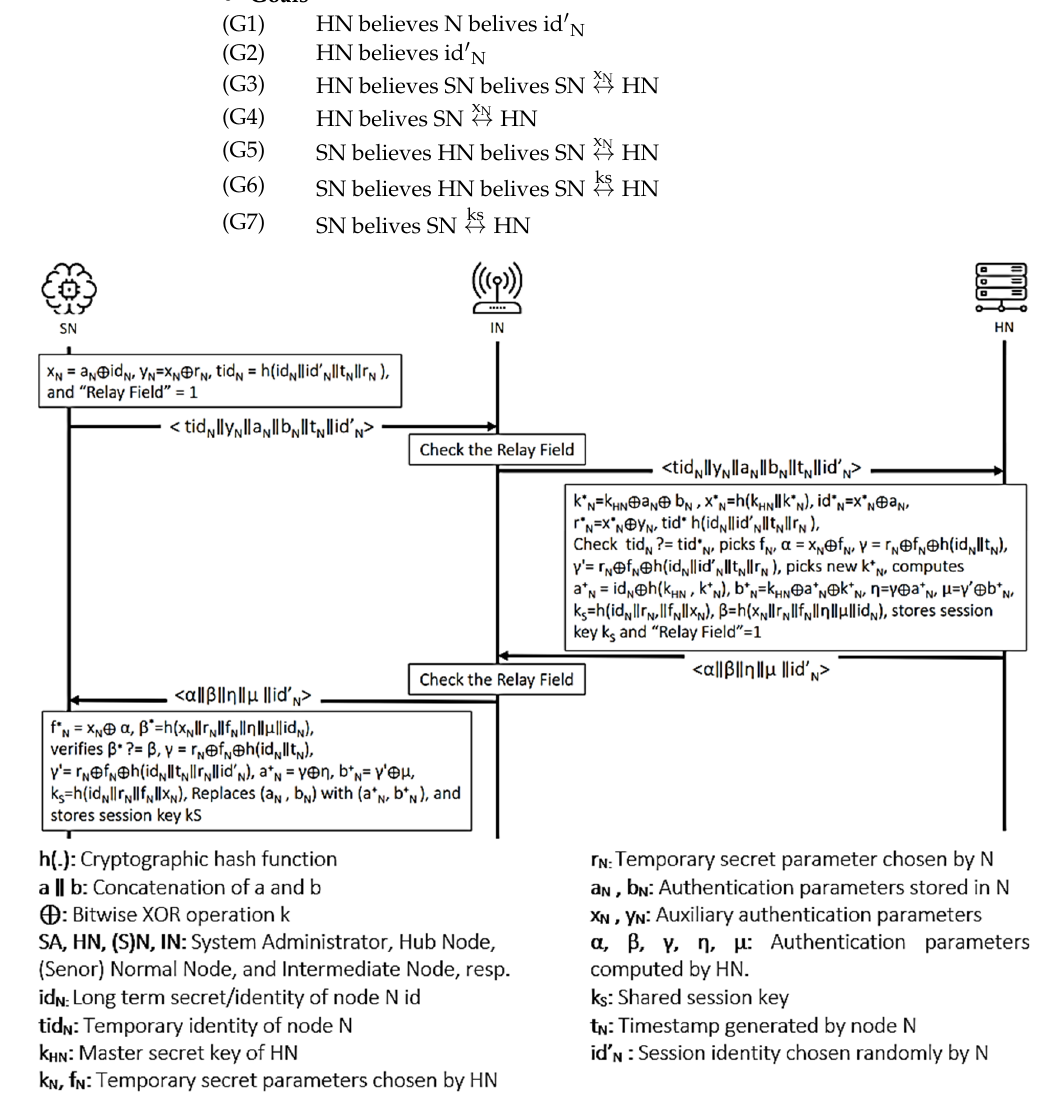
Figure 4. Khan et al.’s protocol.